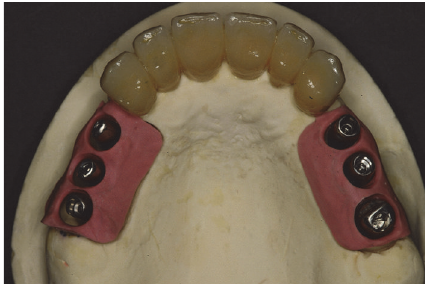
Figure 24: The position of the implants was transferred on the casts used to fabricate the surgical stents.